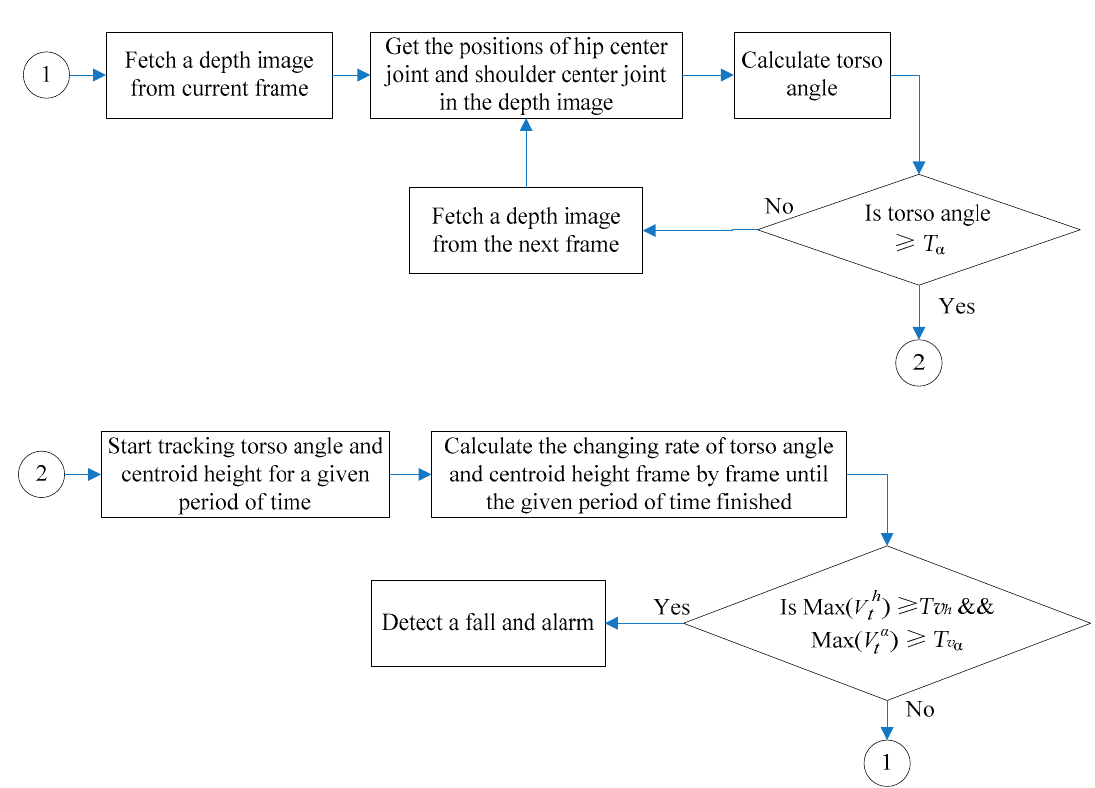
Figure 6. General block diagram of our approach; where (cid:1839)(cid:1853)(cid:1876)((cid:1848) (cid:3047)(cid:3035) ) is the max changing rate of the centroid height in the given period of time and (cid:1839)(cid:1853)(cid:1876)((cid:1848) (cid:3047)(cid:3080) ) the max changing rate of the torso angle in the given period of time. The definitions of the given threshold values are elaborated in Section 4.